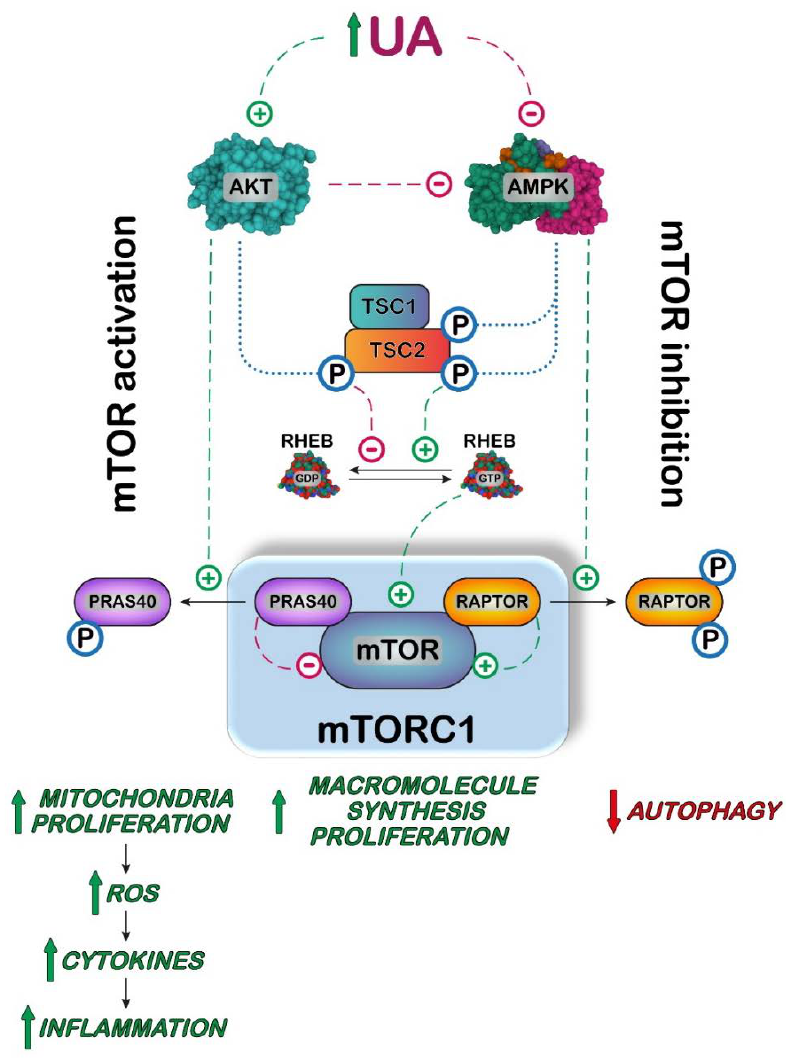
Figure 6. Proposed model in which UA activates mammalian target of rapamycin complex 1 (mTORC1). In several cell models, high UA concentration causes an increase in AKT activity and/or a decrease in AMPK activity causing a potentiation of the regulatory pathway leading to mTORC1 activation. Activated AKT phosphorylates tuberous sclerosis complex 2 (TSC2) leading to the release of the dimer tuberous sclerosis complex 1/2 (TSC1/TSC2) from the mTORC1 complex. Since the dimer is an activator of the GTPase activity of RAS homologous enriched in brain (RHEB), this G-protein binds GTP for long time, thereby activating mTORC1. AKT also directly activates mTORC1 by phosphorylating the mTOR inhibitor proline-rich AKT substrate of 40 kDa (PRAS40), which is then released from the complex. On the contrary, phosphorylation of TSC2 by AMPK increases the concentration of the dimer TSC1/TSC2, thus favoring the GTPase activity of RHEB and therefore inactivating mTORC1. The inhibitory activity of AMPK is also exerted by phosphorylation and consequent release of the mTOR activator regulatory associated protein of mTOR (RAPTOR). Therefore, activation of AKT and inhibition of AMPK cause an increase in mTORC1 activity leading to an increase in the rate of synthesis of proteins, lipids, and nucleotides, while autophagy is inhibited. mTORC1 activation also promotes mitochondria proliferation, producing an increase in intracellular ROS, responsible for an increase in cytokines and chemokines production, leading to inflammation.